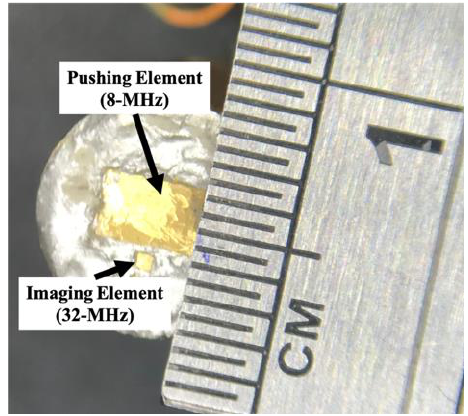
Figure 1. Photograph of the dual-element transducer. The low-frequency pushing element of 8-MHz was used to create a radiation force to induce a SW in tissues. The high-frequency imaging element was used to monitor the motion of the induced SW. The distance between the pushing and imaging elements is 1.5 mm.